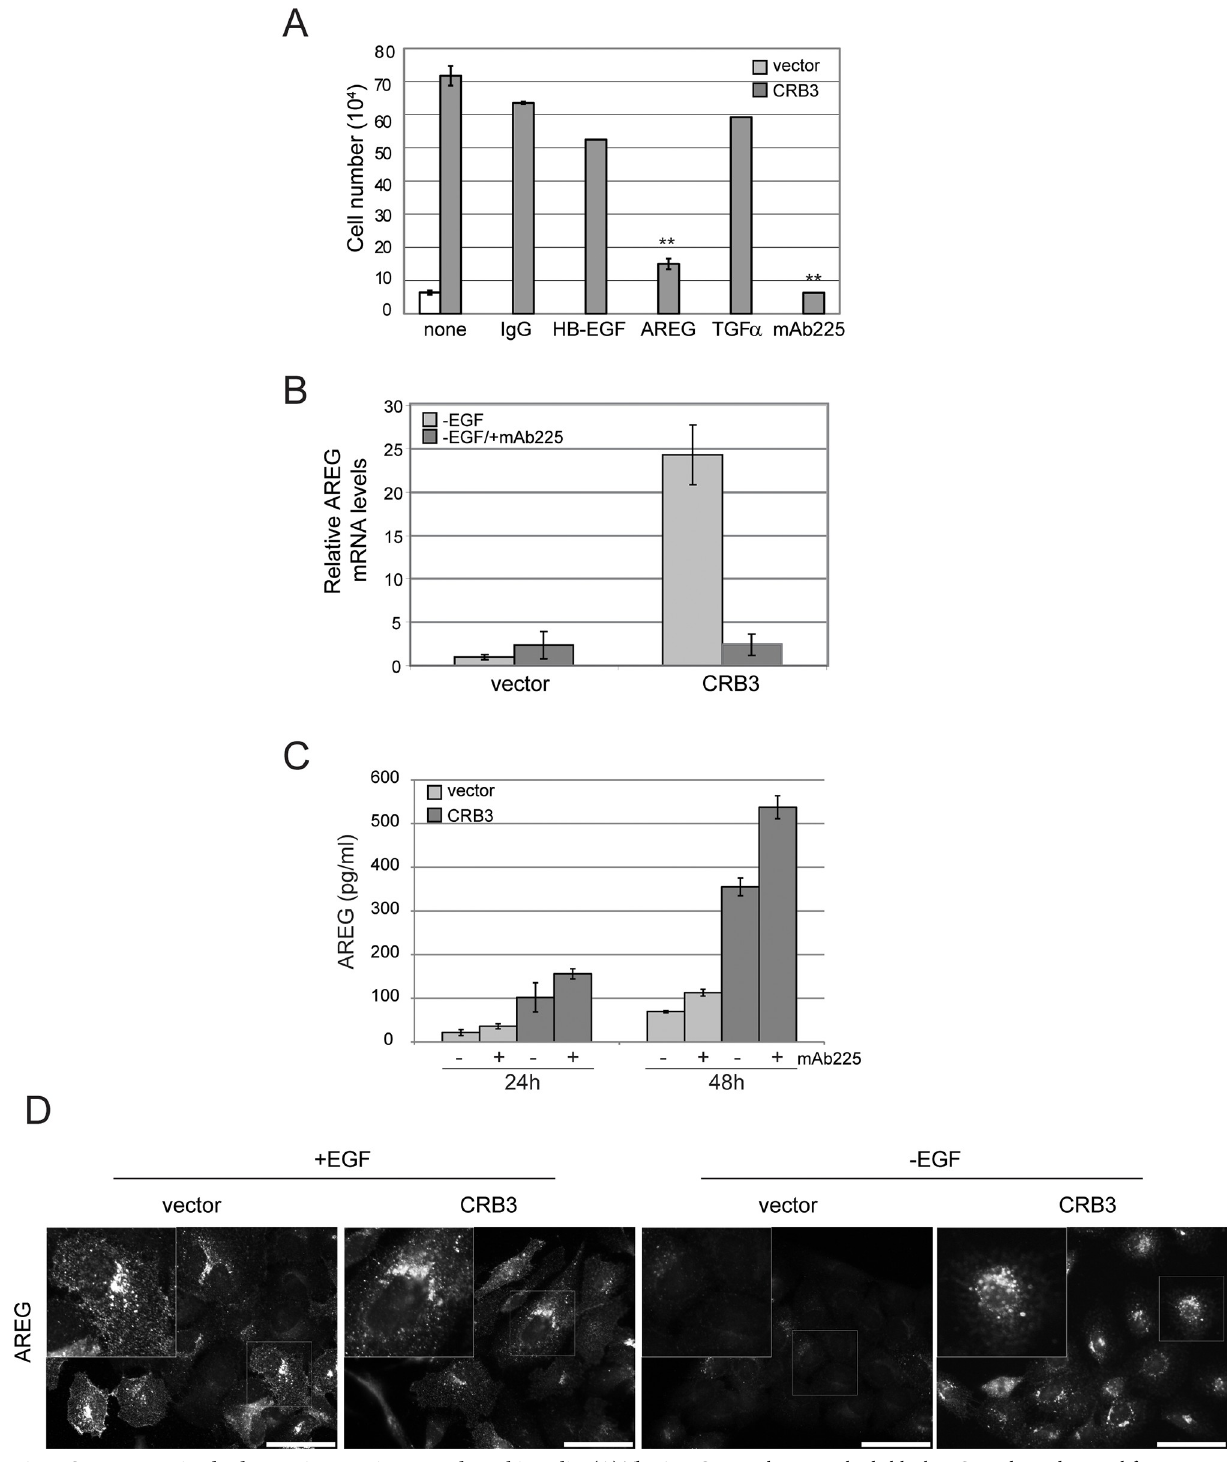
Fig 3. CRB3 expression leads to an increase in secreted amphiregulin. (A) The AREG neutralizing antibody blocks EGF-independent proliferation in CRB3 expressing cells. Results shown are the average +/- SEM of 2 independent experiments with each condition in triplicate (n = 6) ( �� p < 0.01 for AREG and mAB225 compared to IgG using Students t test). (B) qRT-PCR showing that AREG mRNA levels are increased in CRB3-expressing cells, and the autocrine loop leading to increased AREG mRNA expression is blocked with mAb225. Results shown are the average +/-SEM of triplicate samples and are representative of three independent experiments. (C) AREG ELISA assay showing an increase in AREG protein levels in the conditioned media